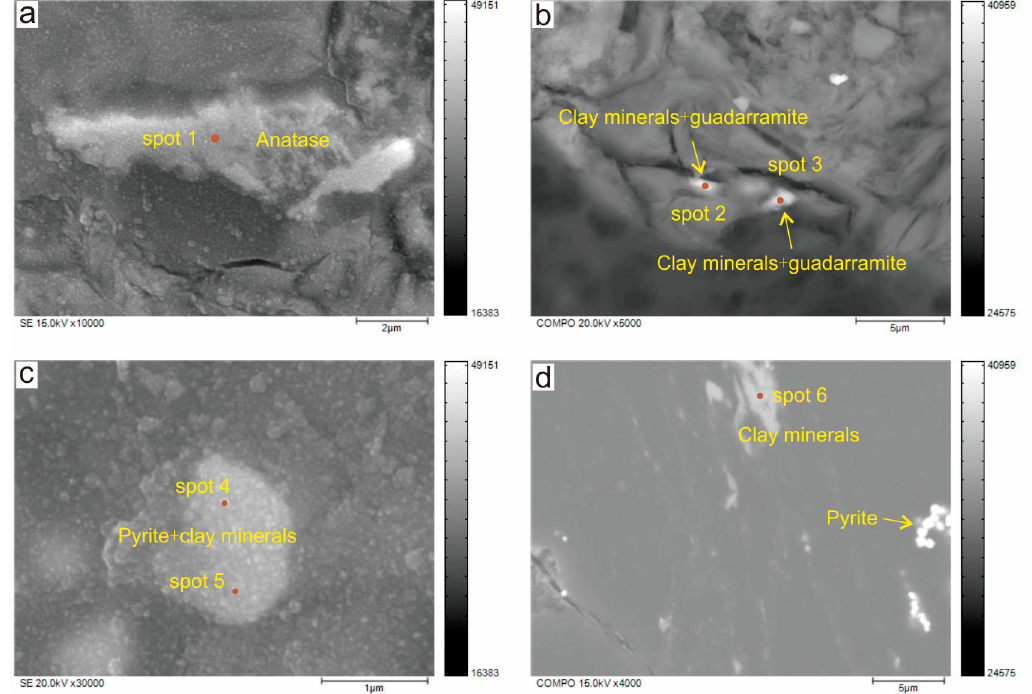
Figure 5. Minerals in the Rongyang coals: ( a ) anatase (EMPA, SE images); ( b ) mixture of guadarramite and clay minerals (EMPA, BSE images); ( c ) mixture of clay minerals and pyrite (EMPA, SE images); and ( d ) clay minerals and pyrite (EMPA, BSE images).